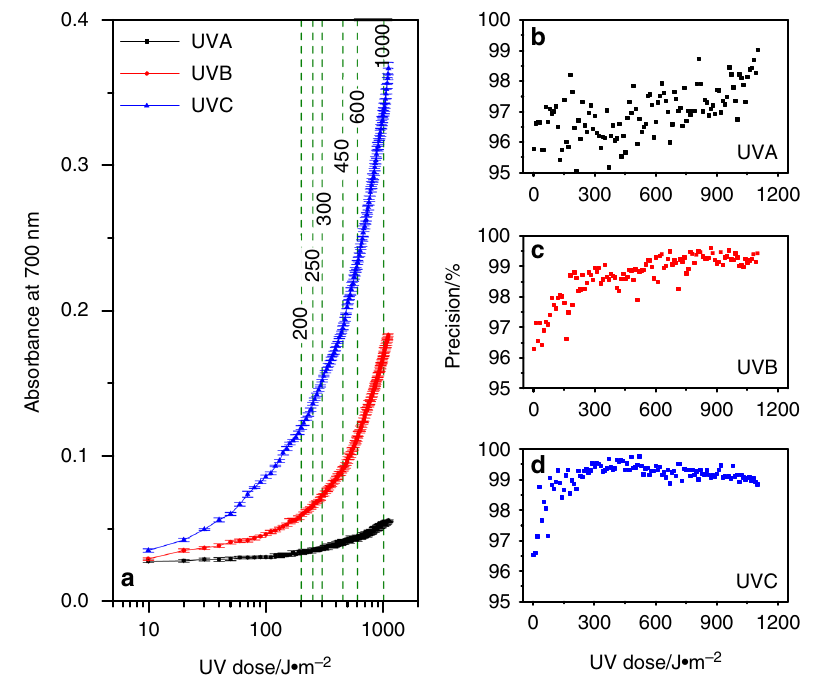
Fig. 3 Performance of PMA – LA sensor across the UVB MED range for different skin types. a UVR dose-dependent colorimetric response of PMA – LA sensor demonstrating the sensor ’ s ability to differentiate UVA, B, and C even at extremely low dosages, as re fl ected from logarithmic X-axis. Each data point represents an average of the colorimetric response obtained from 12 independent sensors and the associated standard deviation. The highlighted responses correspond to the UVB MED for types I – VI skins (200, 250, 300, 450, 600, and 1000 J m − 2 , respectively). b – d The precision of PMA – LA sensors at each of the UV doses at 10 J m – 2 increments, as calculated from the data presented in